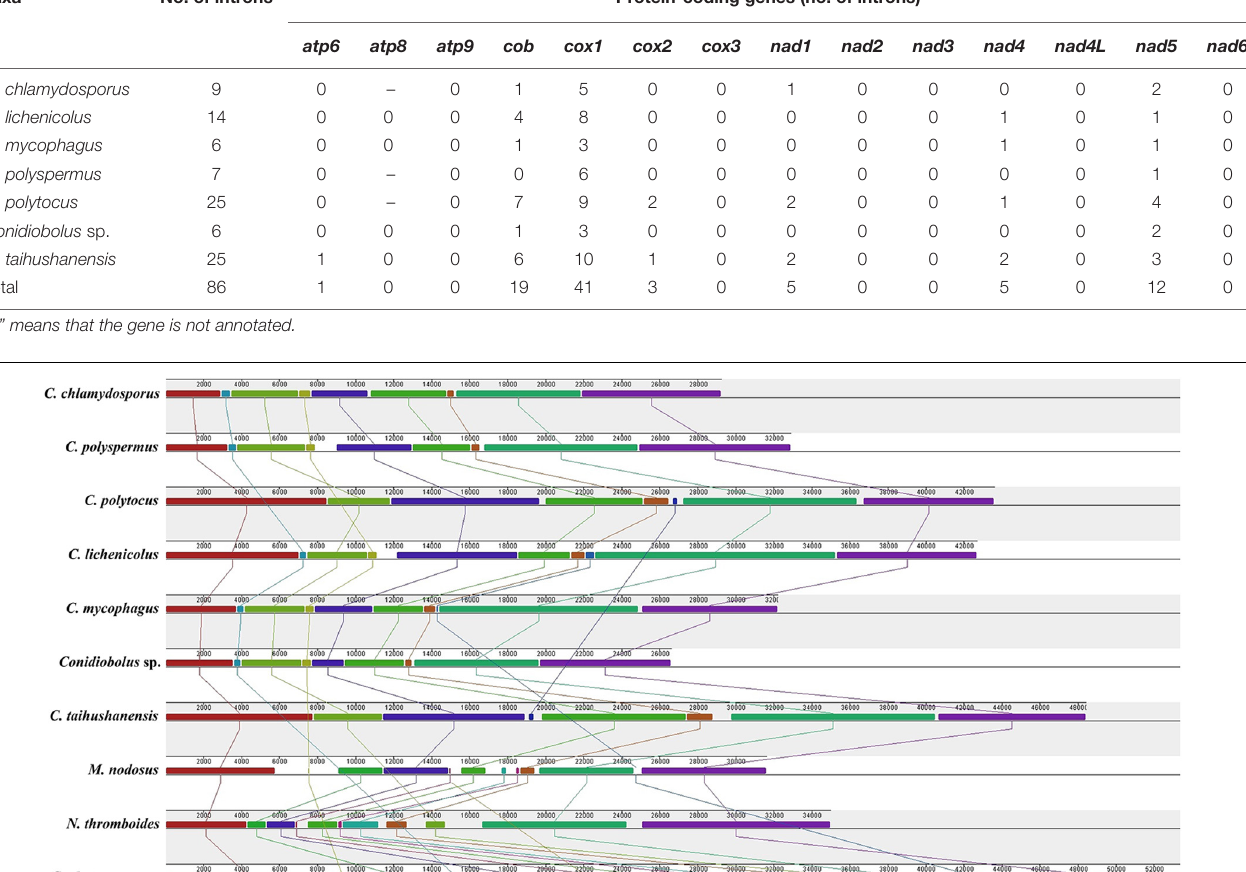
was GTR + I + G. The final average standard deviation of split frequencies was 0.000748. The ML and BI phylogenetic trees shared a similar topology, and the ML tree was presented with ML bootstrap/BI posterior probability values of robust clades at relative branches ( Figure 6 ). The seven Conidiobolus s.s. species formed a monophyletic group (100/1.00). Three related Conidiobolus s.l. species C. heterosporum , M. nodosus , and N. thromboides were basal to the seven Conidiobolus s.s.